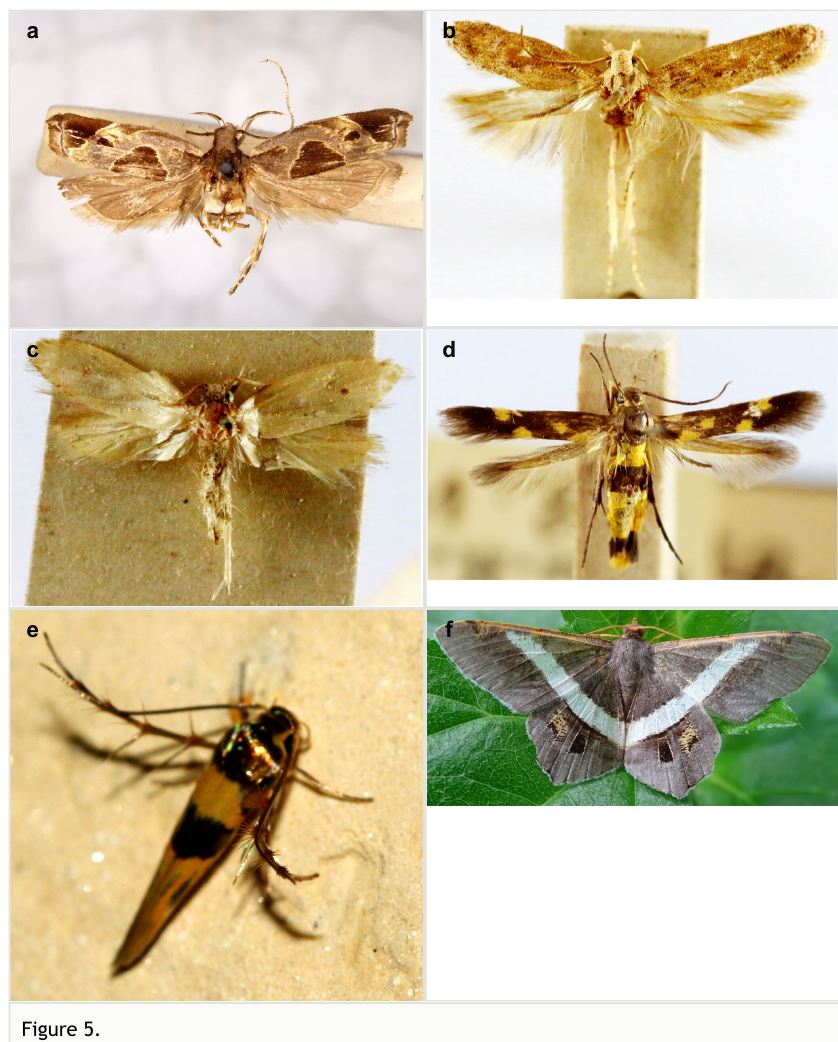
Adults: a : Helcystogramma hibisci b : Phthorimaea operculella c : Pseudodoxia albinea d : Eretmocera impactella e : Stathmopoda sp. f : Chiasmia